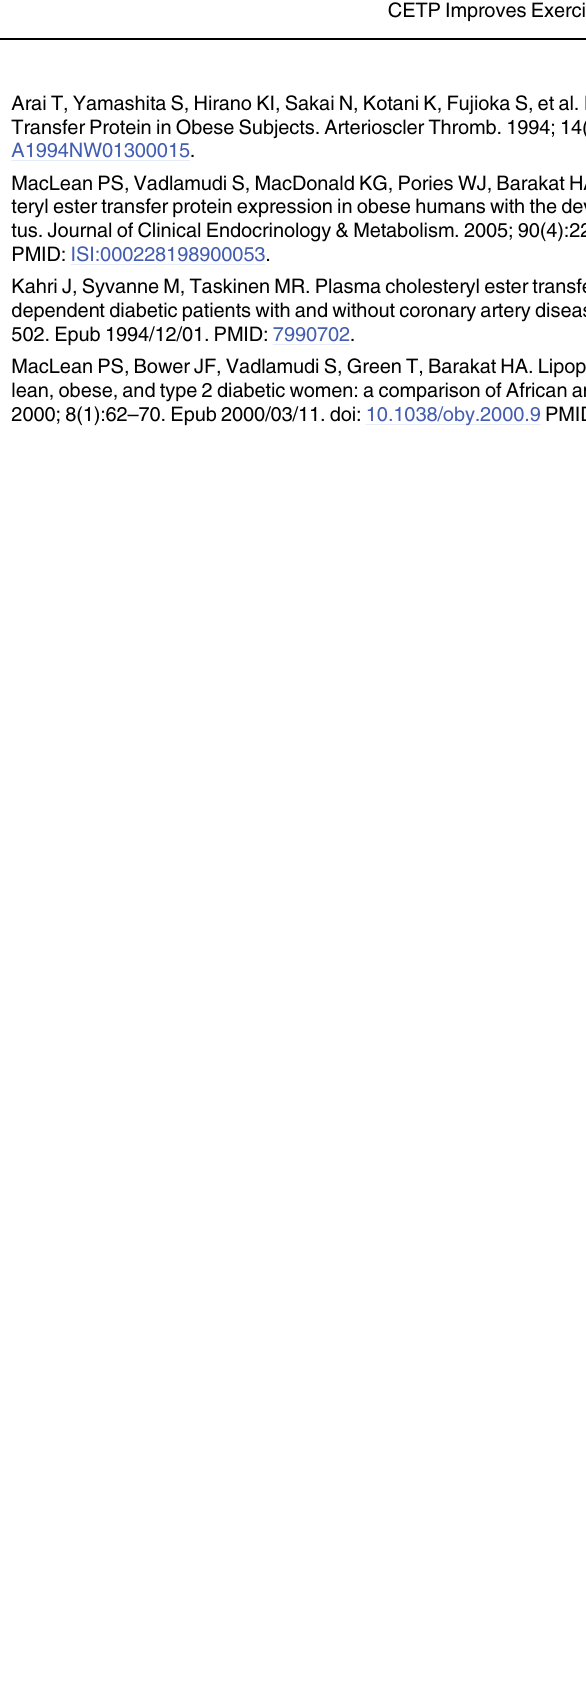
PLOS ONE | DOI:10.1371/journal.pone.0136915 August 27,